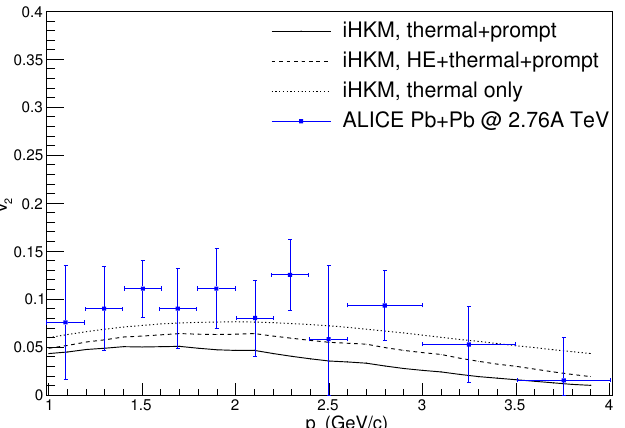
Figure 4. The dependency of the photon v 2 coefficients on p T calculated in iHKM for the case of √ s NN = 2.76 TeV with the centrality c = 0–40% in comparison with the LHC Pb+Pb collisions at the measured experimental data [73]. The results obtained with and without taking into account the hadronization emission are demonstrated, as well as the results including only thermal photon component (without prompt photon